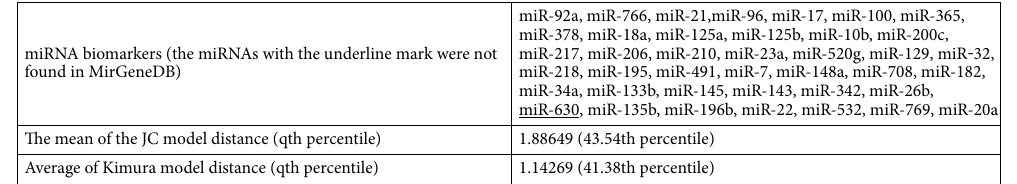
Table 8. The pairwise distance of miRNAs related to the apoptosis of colorectal cancer.